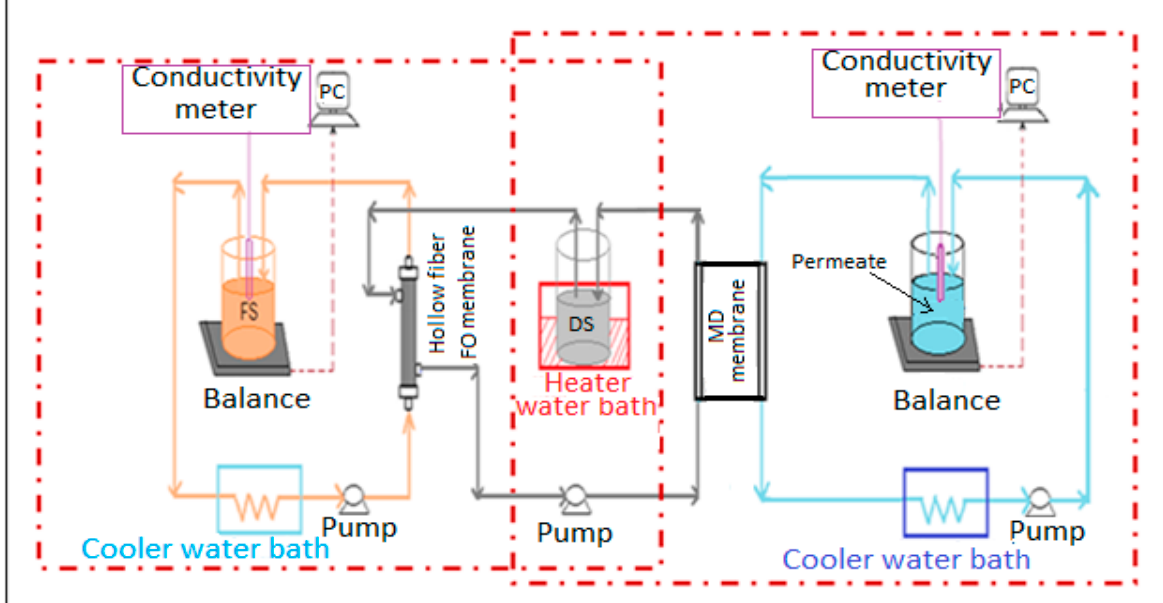
Figure 1. Schematic diagram of the individual FO membrane process and MD membrane process in dashed rectangles and the integrated FO-MD process as a whole.